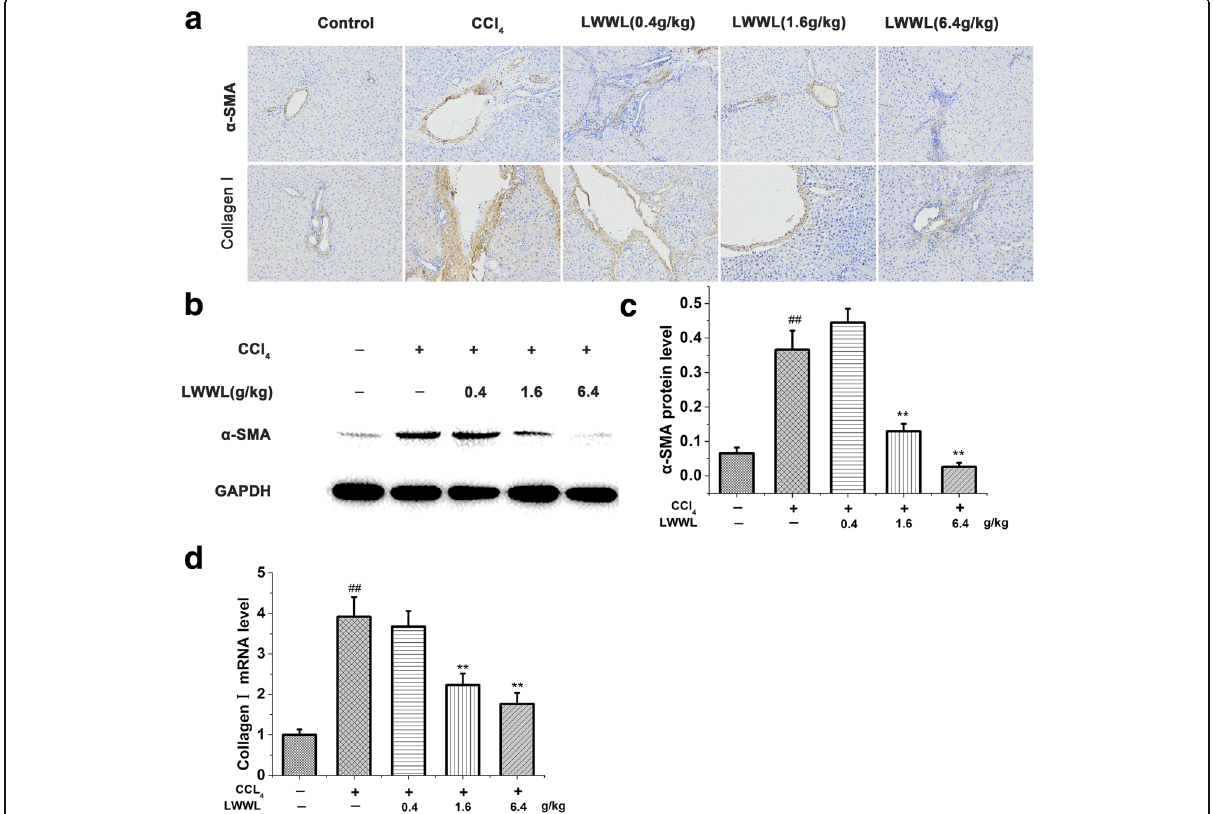
Fig. 3 LWWL inhibited HSCs activation in CCl 4 -induced hepatic fibrosis rats. a Immunohistochemical analysis of α -SMA and collagen I (× 200); b Western blot analysis of α -SMA; c Densitometry of α -SMA expression levels; d RT-PCR for collagen I. ## P < 0.01 vs. normal group; ** P < 0.01 vs. model